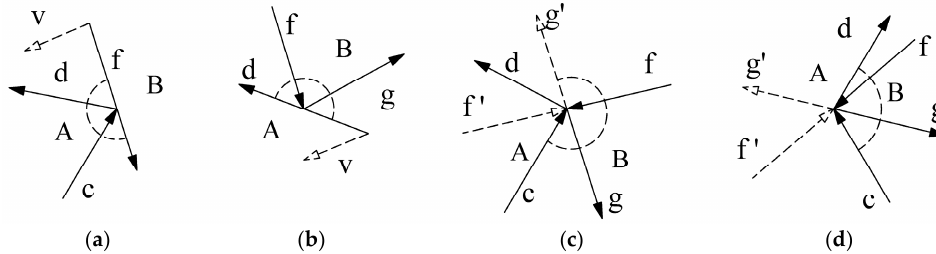
Figure 7. The feasible boundary for all types of touching groups. ( a ) The second type; ( b ) The third